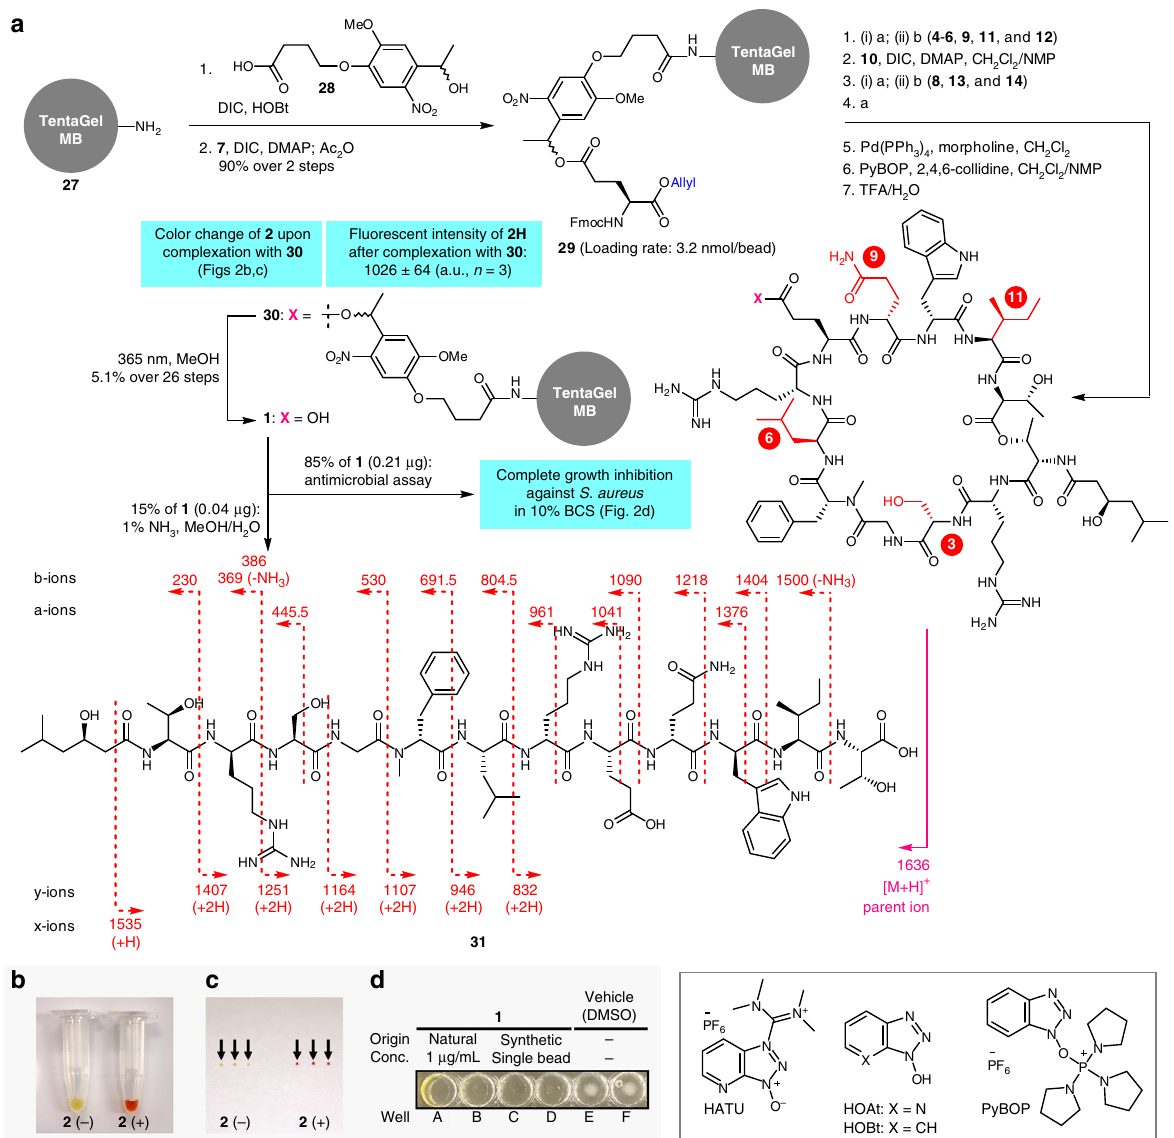
Fig. 2 Synthesis and evaluation of bead-linked lysocin E. a Synthesis of bead-linked lysocin E 30 and establishment of the OBOC protocols. The fragmentation pattern of hydrolyzed 31 on MALDI-MS/MS is also shown. Reagents and conditions: a 20% piperidine/NMP, b HATU, HOAt, i -Pr 2 NEt, NMP, 40 °C (rt for 9 ). a.u. arbitrary unit, DIC N , N ’ -diisopropylcarbodiimide, DMAP N , N -dimethyl-4-aminopyridine, HATU O -(7-aza-1 H -benzotriazol-1-yl)- N , N , N ’ , N ’ -tetramethyluronium hexa fl uorophosphate, HOAt 1-hydroxy-7-azabenzotriazole; HOBt 1-hydroxybenzotriazole; NMP N -methyl-2-pyrrolidone; PyBOP benzotriazol-1-yloxy)tripyrrolidinophosphonium hexa fl uorophosphate; TFA tri fl uoroacetic acid. b Color of 30 before ( 2 ( − )) and after ( 2 ( + )) incubation with 2 . c Color of the 3 beads of 2 ( − ) and 2 ( + ). Each bead is indicated by an arrow. d Growth inhibition of Staphylococcus aureus Smith ATCC 13709 caused by natural (0.04 μ g per well, wells A and B) and 85% of single bead-derived 1 (wells C and D) in 10% BCS-doped Mueller Hinton Broth (40 μ L) as growth medium. DMSO was used as vehicle control (wells E and F). Evaluation of the growth inhibitory activity was conducted as duplicate experiments. BCS bovine calf